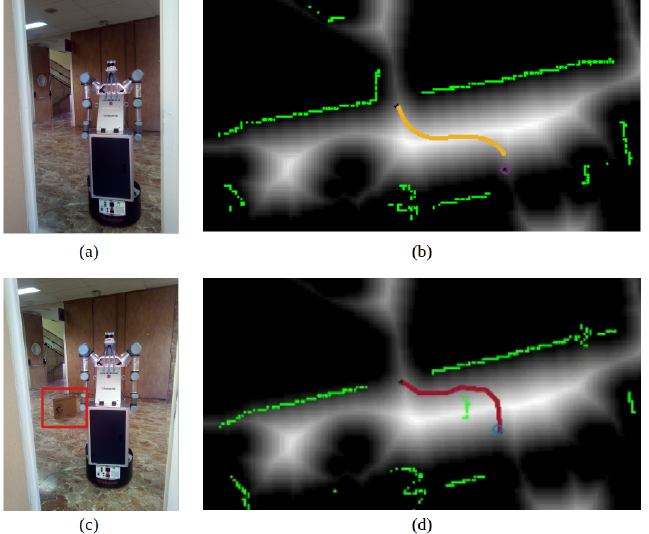
Figure 22. Replanning behavior: ( a ) initial scenario, ( b ) initial planned path (yellow) on the velocity map, where green is 2D LiDAR data, ( c ) modified scenario with an unmapped box, ( d ) modified path considering the